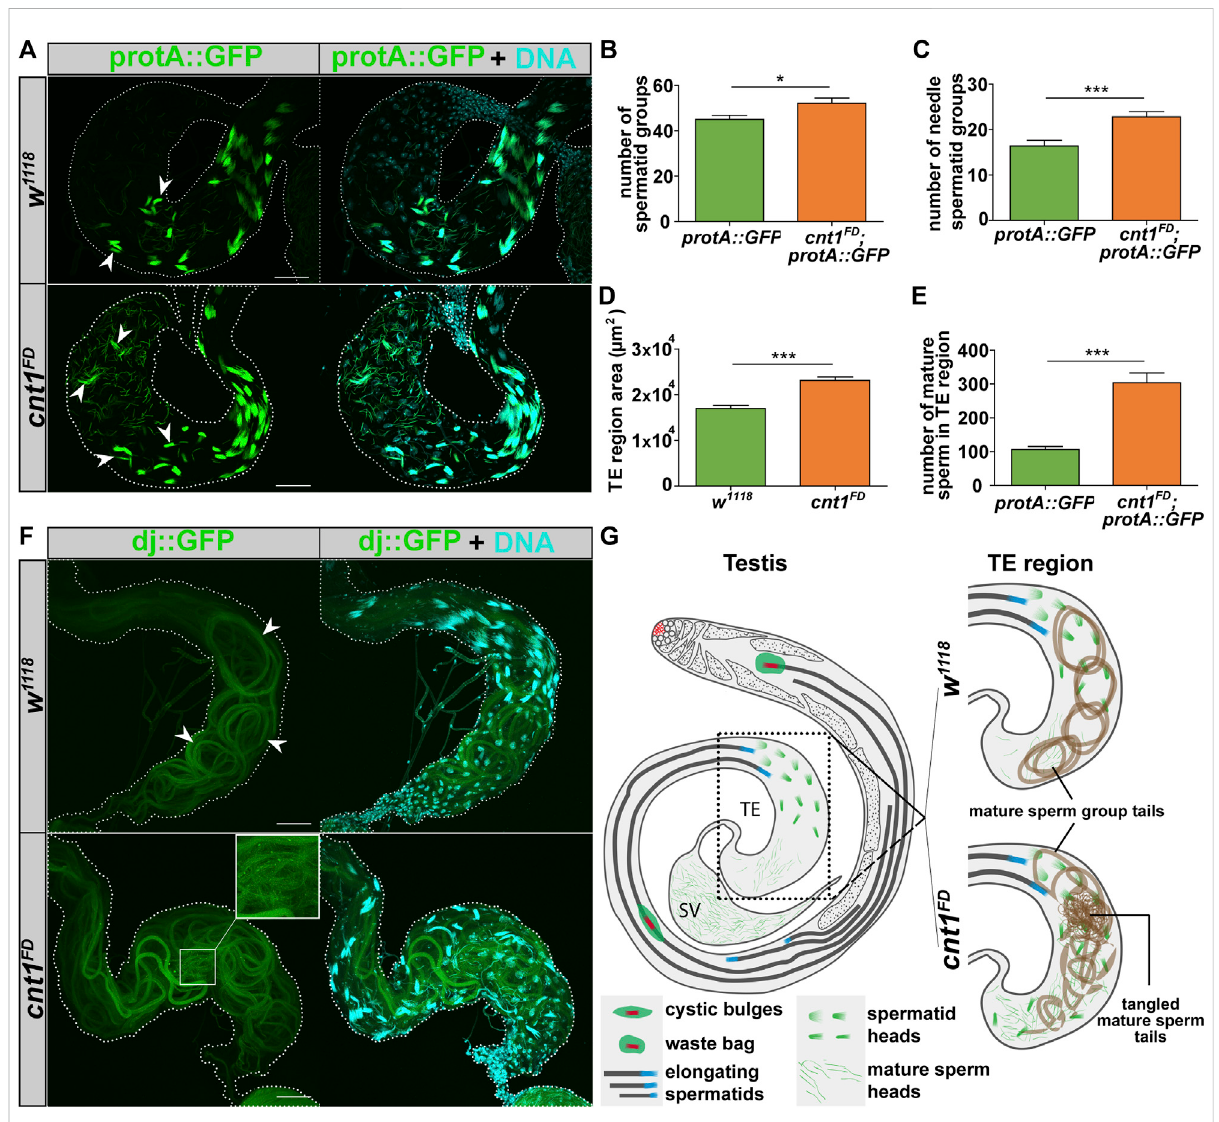
FIGURE 5 The cnt1 mutation increases the number of spermatid groups and spermatozoa in the TE region and causes tail miscoiling. (A) Microscopic observationofspermatidsexpressingprotamineAsignalsintheregionoftheterminalepitheliumofthetestis.Thearrowheadsshowexamplesofthe needle spermatid groups. W 1118 is used as a control. In w 1118 , spermatid groups expressing protamine A are observed in the fi rst half of the TE region, whereasthespermatidgroupsarescatteredthroughouttheTEregioninthe cnt1 FD mutants.ProtamineA(green),DNA(cyan).Scalebar:40 µm. (B) Numberofspermatidgroups;n ≥ 10. (C) Numberofneedle-stagespermatidgroups;n ≥ 10. (D) SizeoftheTEregion;n ≥ 28. (E) Numberofmature sperm in the TE region; n ≥ 10. Signi fi cance was analyzed with a one-tailedStudent ’ s t-test and labeled as follows: * p < 0.05, *** p < 0.001. Error bars are shown as mean ± SEM. (F) Microscopic observation of coiled tails of mature sperm groups expressing a “ dj ” signal in the region of the terminal epithelium of the testis. W 1118 is used as a control. In w 1118 , the tails of the mature sperm group were well organized and coiled (white arrowhead).